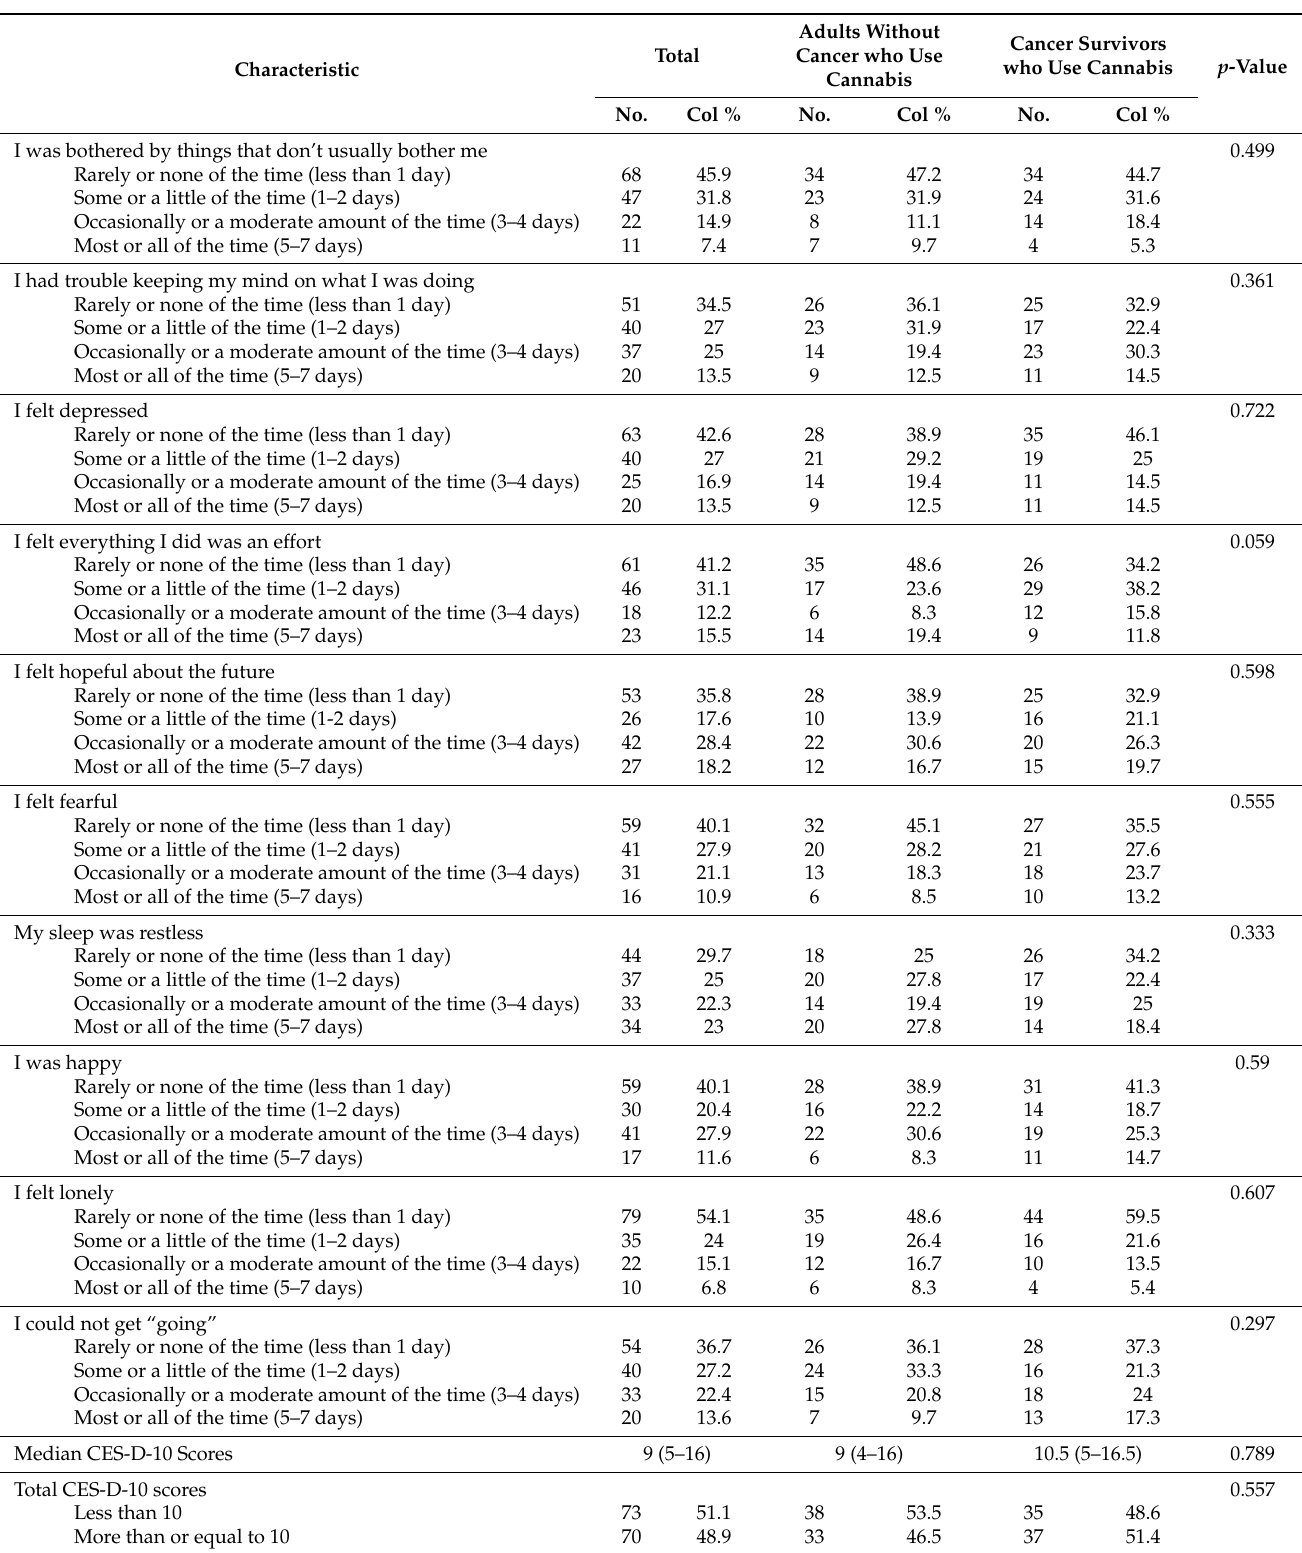
Table 3. Components of the CES-D-10 questionnaire among cancer survivors and adults without cancer ( n =